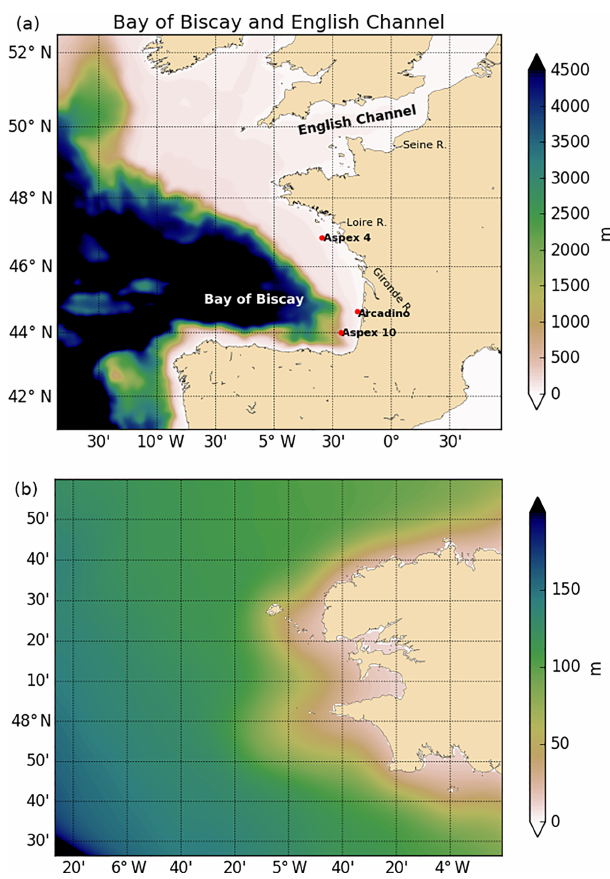
Figure 1. Bathymetry of the modelled region (a) . Red points corre- spond to the mooring sites used for model validation. A zoomed-in area around 48 ◦ N is represented in panel (b)